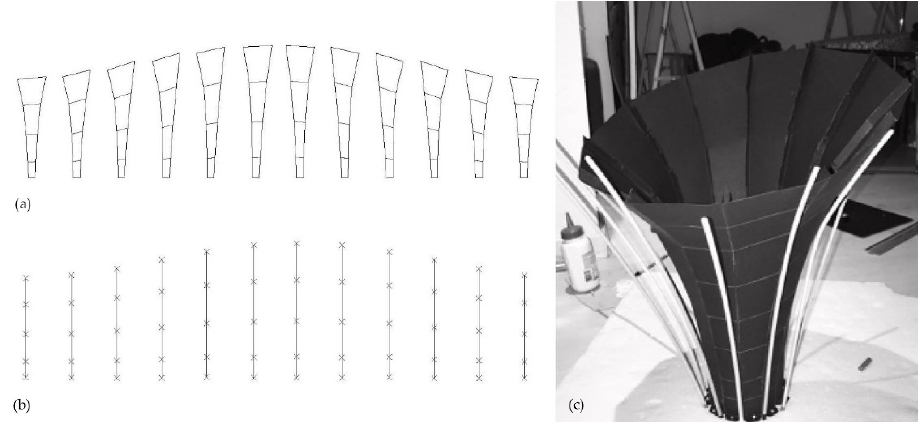
Figure 9. ( a ) Layout for paper strips, ( b ) goal lengths, ( c ) assembled paper model.